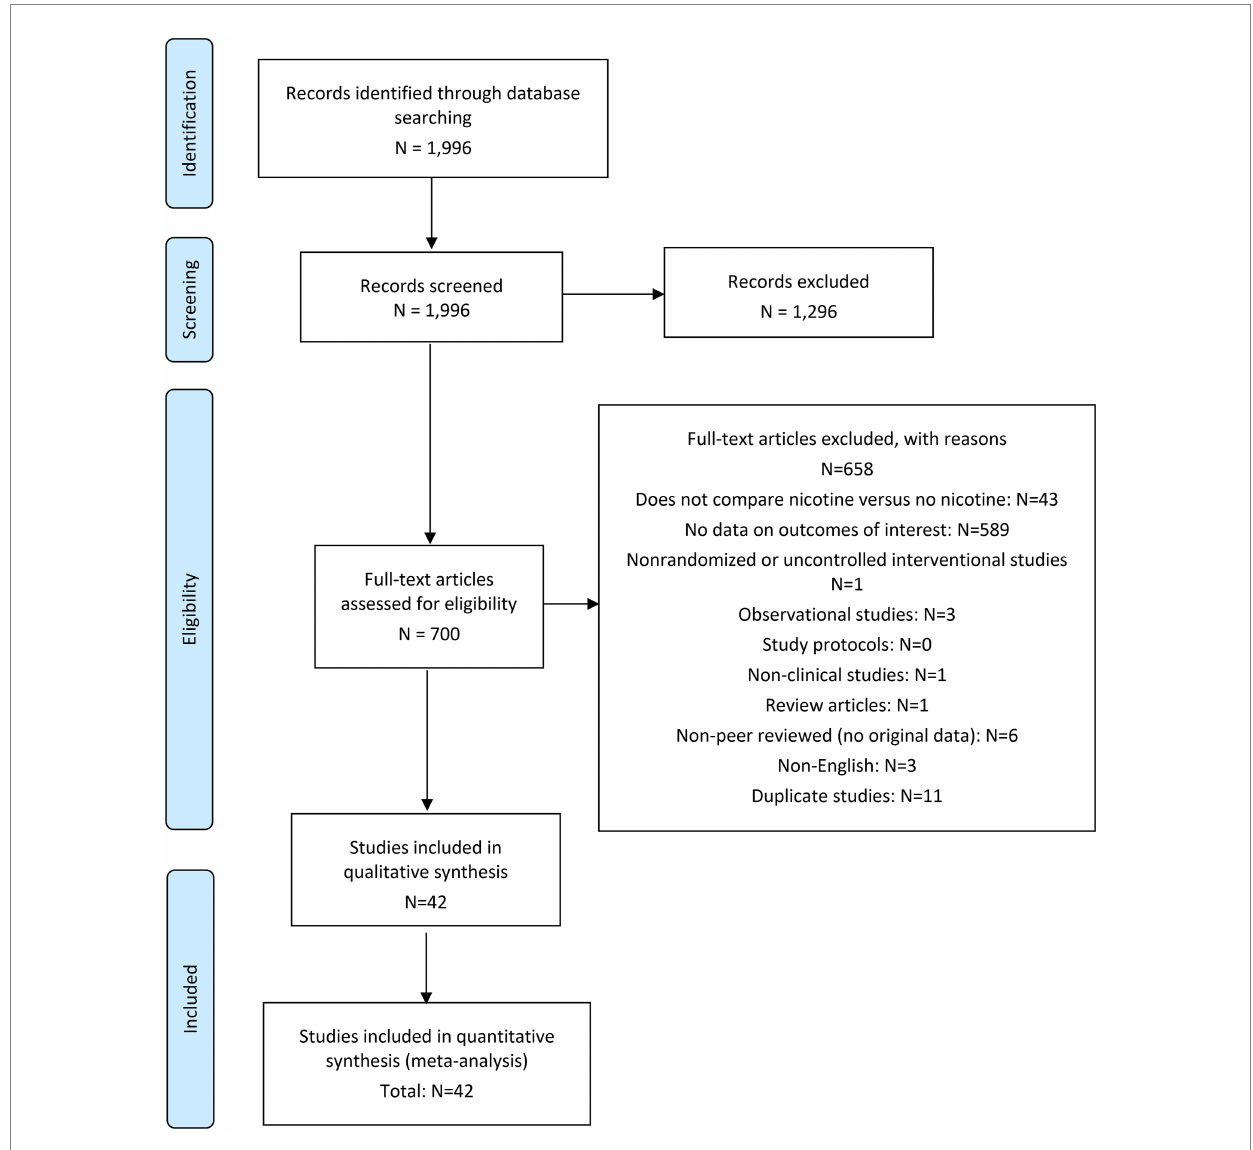
FIGURE 1 PRISMA flow